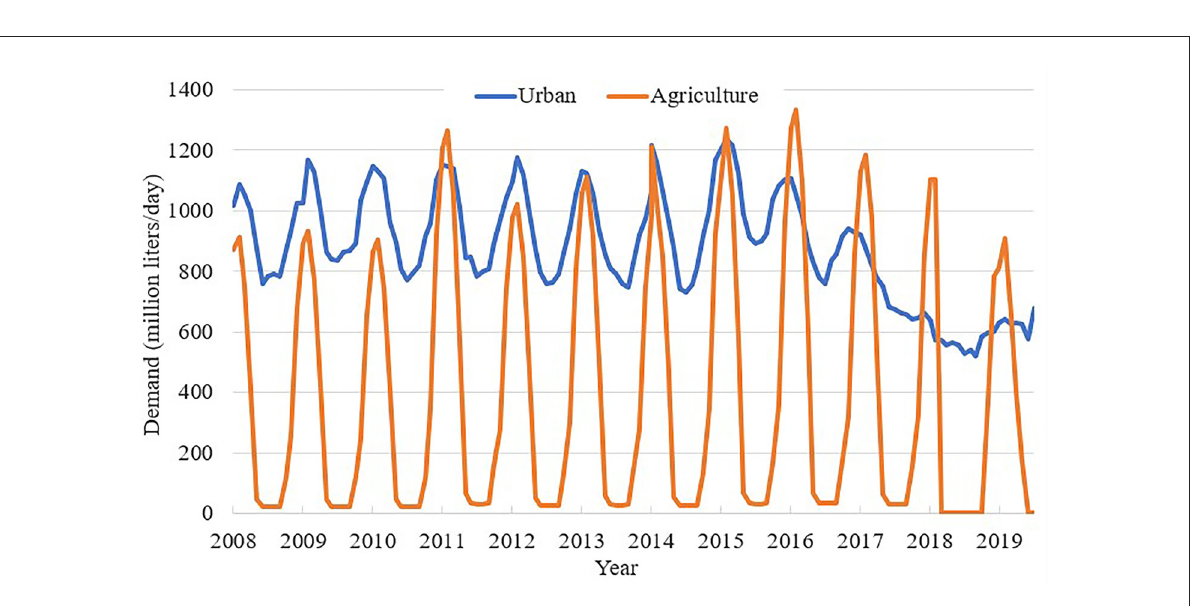
FIGURE6 “Big Six” urban and agricultural water use